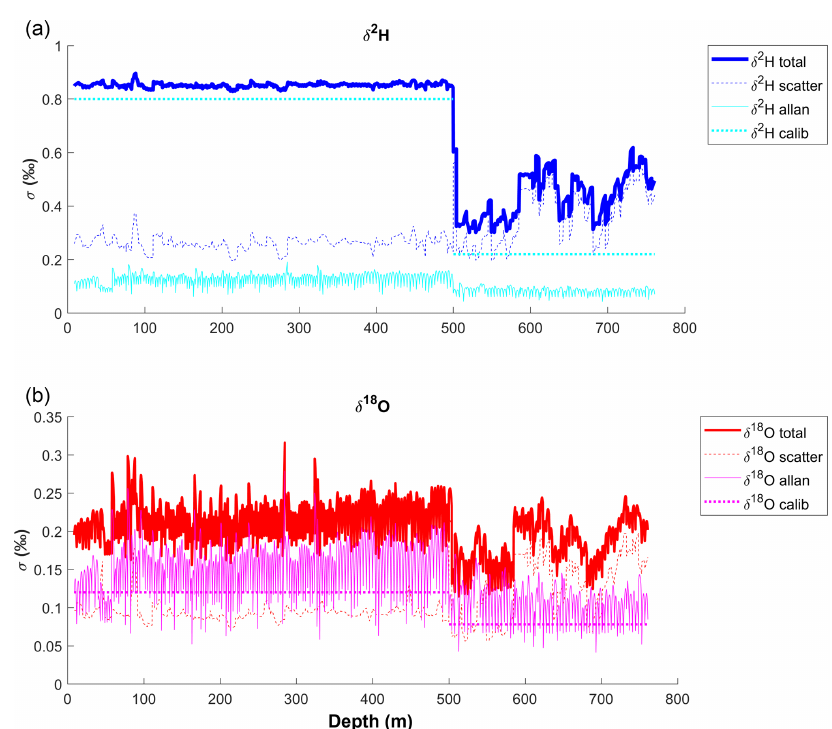
Figure 7. Total uncertainty vs. depth, along with each individual error factor in per mil. (a) : δ 2 H. (b) : δ 18 O. There is a noticeable discontinuity at 500m; the melting campaign was paused at 500m in 2013, and melting was resumed in 2014 with a modified set-up. The reduced calibration error in 2014 is responsible for the large step down in total